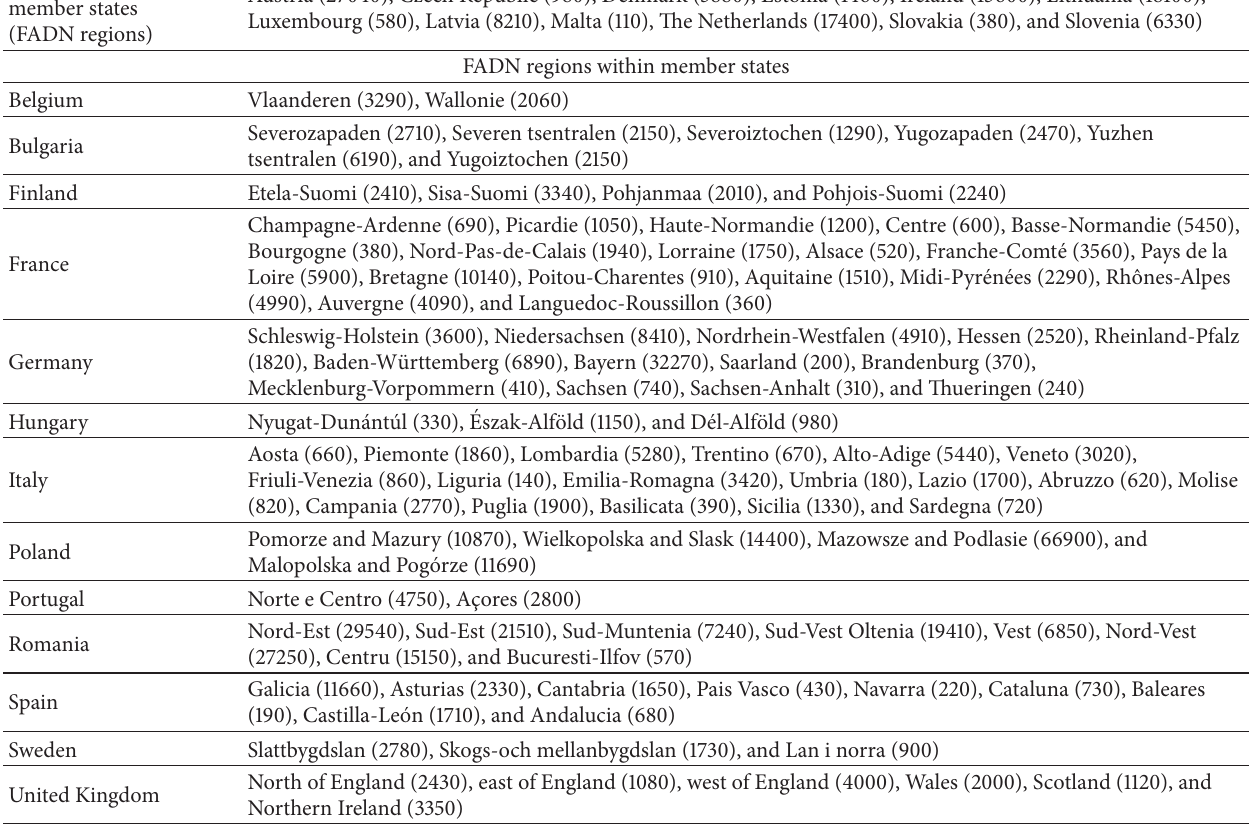
Table 1: Regions (108) and number of farms represented (population of specialised dairy